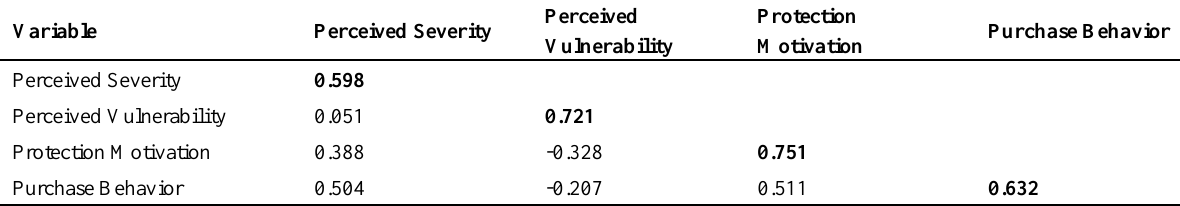
Table 2: Discriminant Validity Evaluation Result